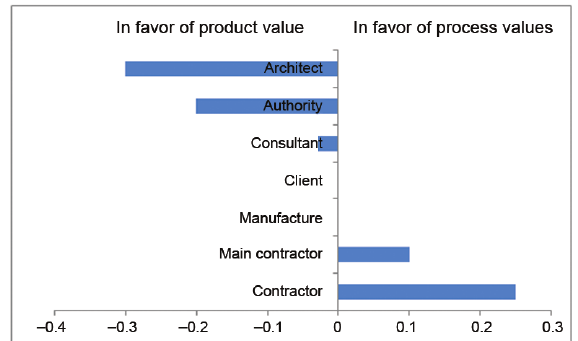
Fig. 1. Difference in average score of product and process values shown per